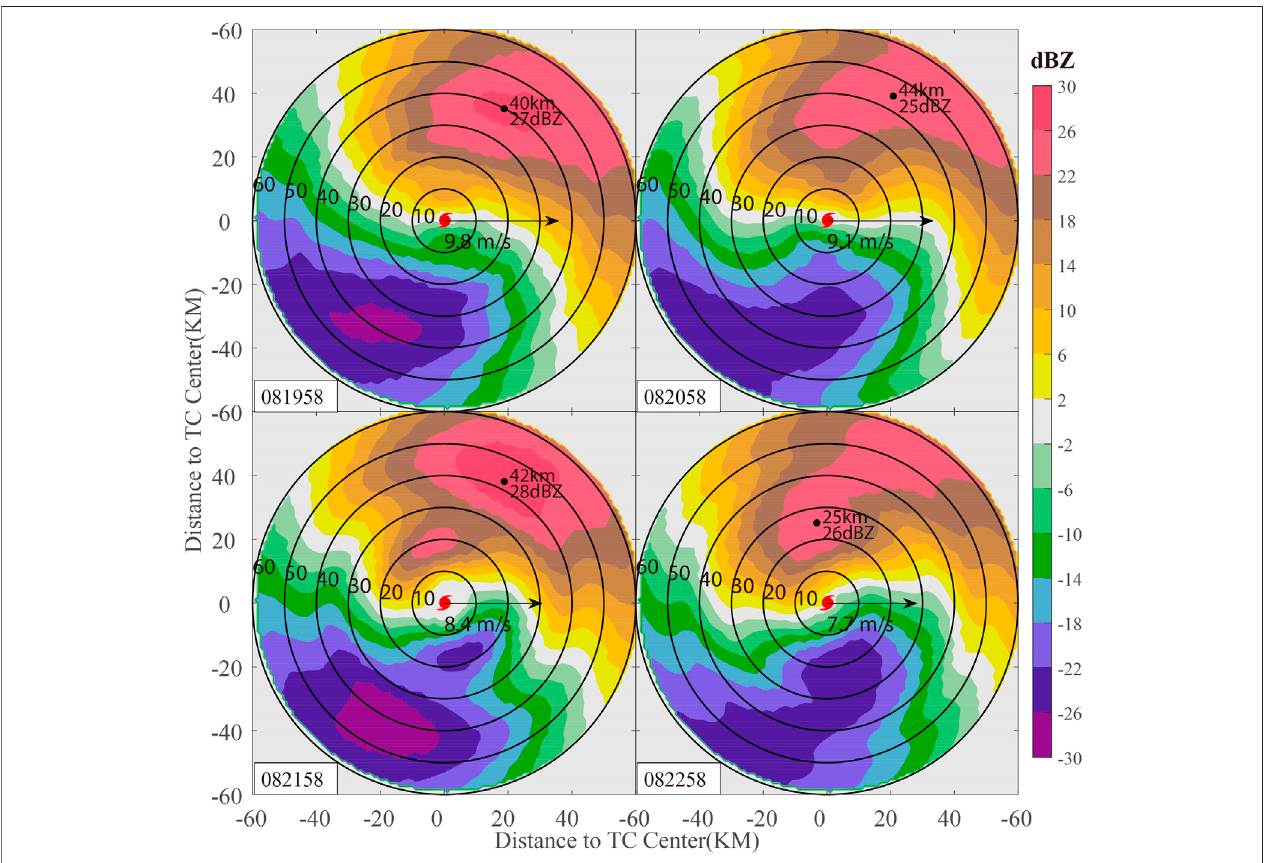
FIGURE 5| Wavenumber-1 component ofthe radar echoaccording to Fourier decomposition at 3 km during 20:00 to 23:00 UTC. The VWS direction isuniformly adjustedtotheright,and thearrowlengthindicatesthesizeoftheVWS. Theblackdotindicatesthepositionofthemaximum amplitudeofwavenumber-1, withthelabel of intensity and distance from TC center. The dotted circle represents the distance to the TC center, marking from 10 to 60 km at intervals of 10 km.